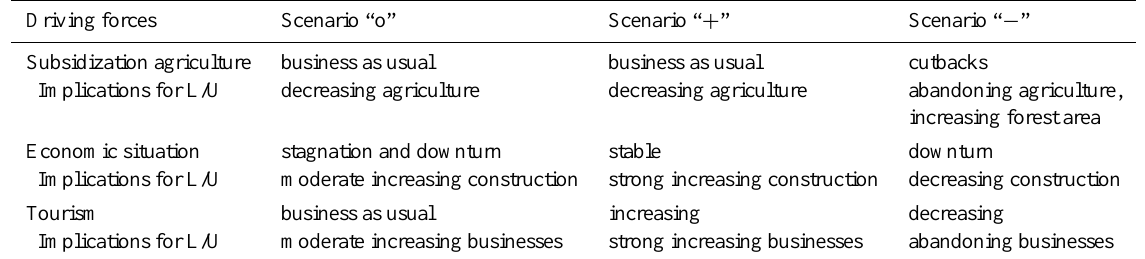
Table 3. The development pathways of major driving forces and their implications for land use within the three scenarios “o”, “ + ” and “ − ”.